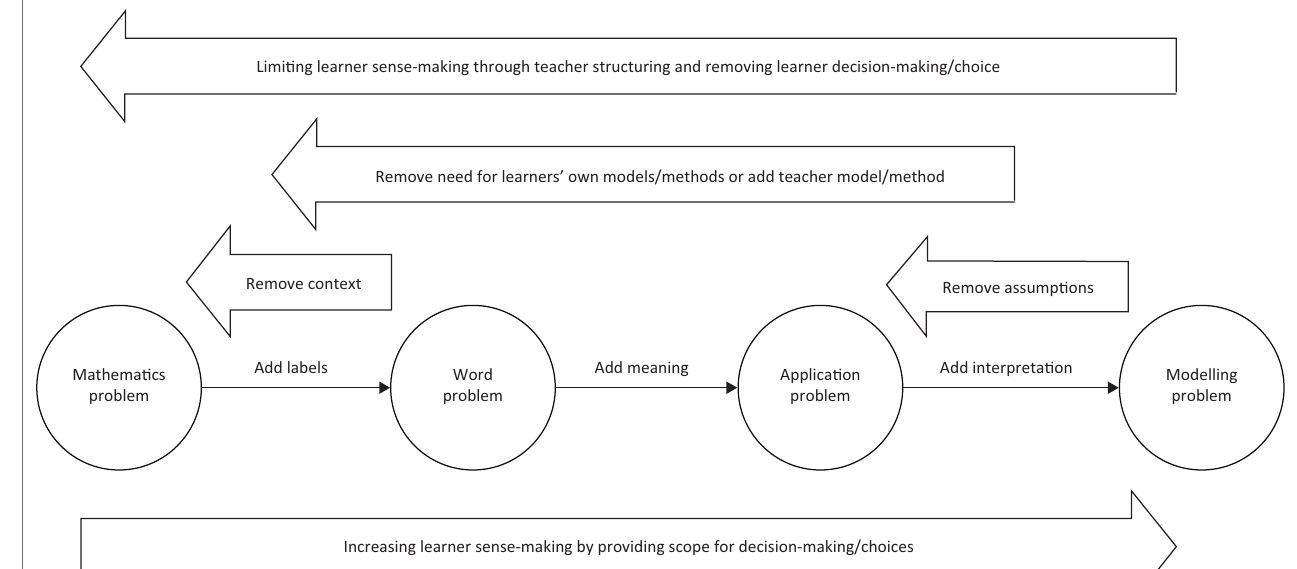
FIGURE 4: Supporting sense-making through learner